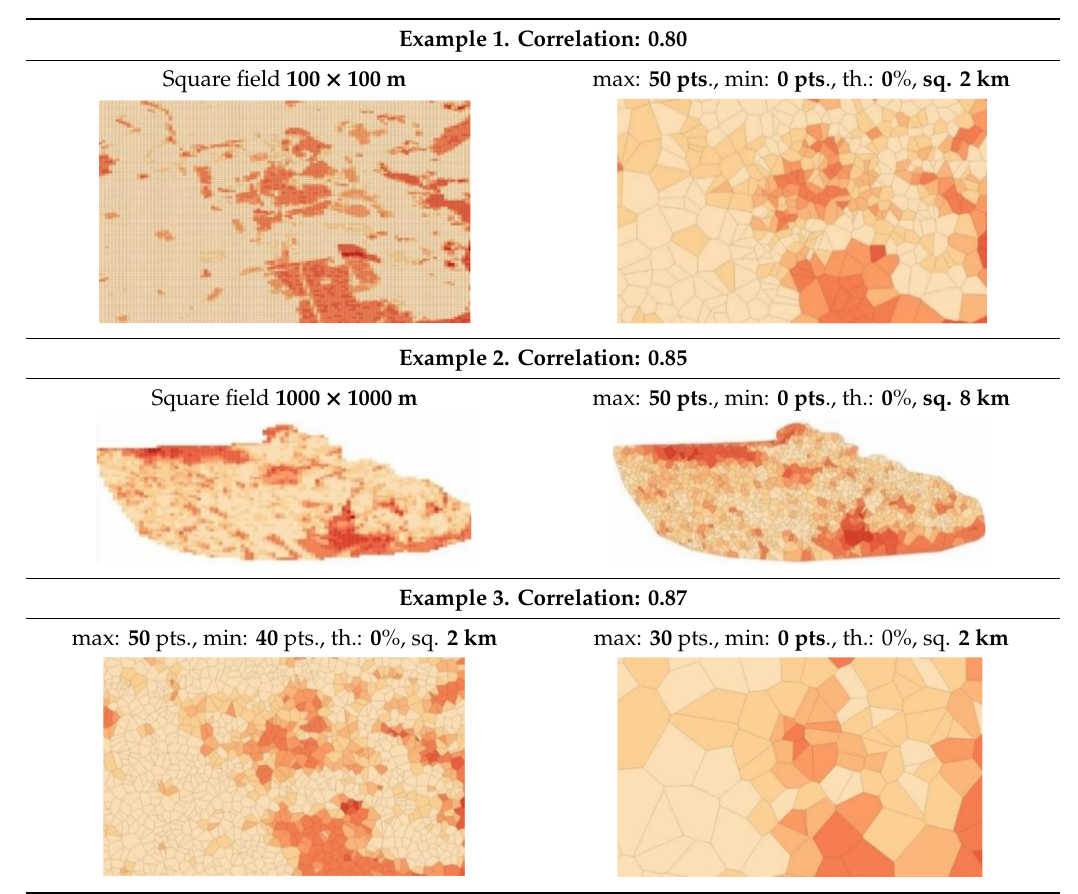
Table 9. Visualizations of passability maps with the highest correlation coe ffi